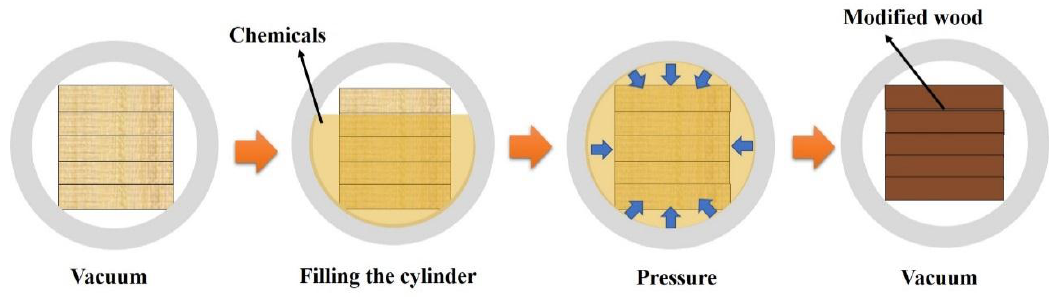
Figure 2. Vacuum pressure impregnation.